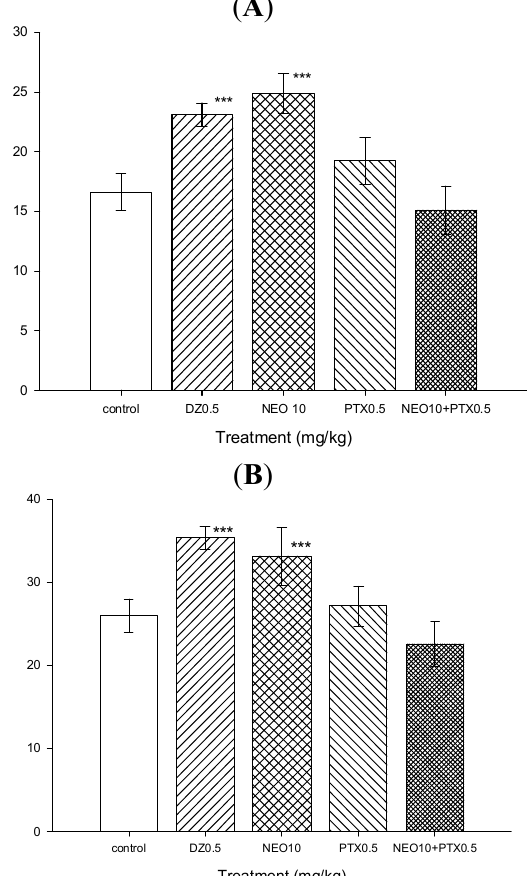
Figure 5. Effects of picrotoxin (PTX) on the anxiolytic-like effects of NEO in hole-board test. ( A ) Rearing number vs. treatment; ( B ) Head dipping number vs.